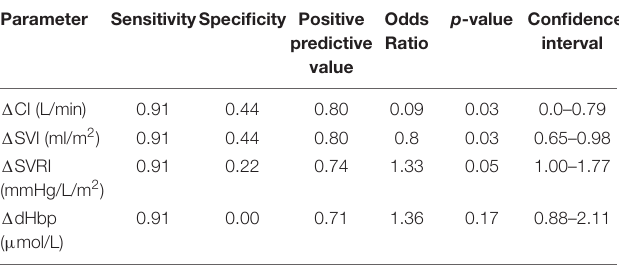
TABLE 4 | Performance diagnostics and odd’s ratio for P1 significant factors. Parameter SensitivitySpecificity Positive predictive